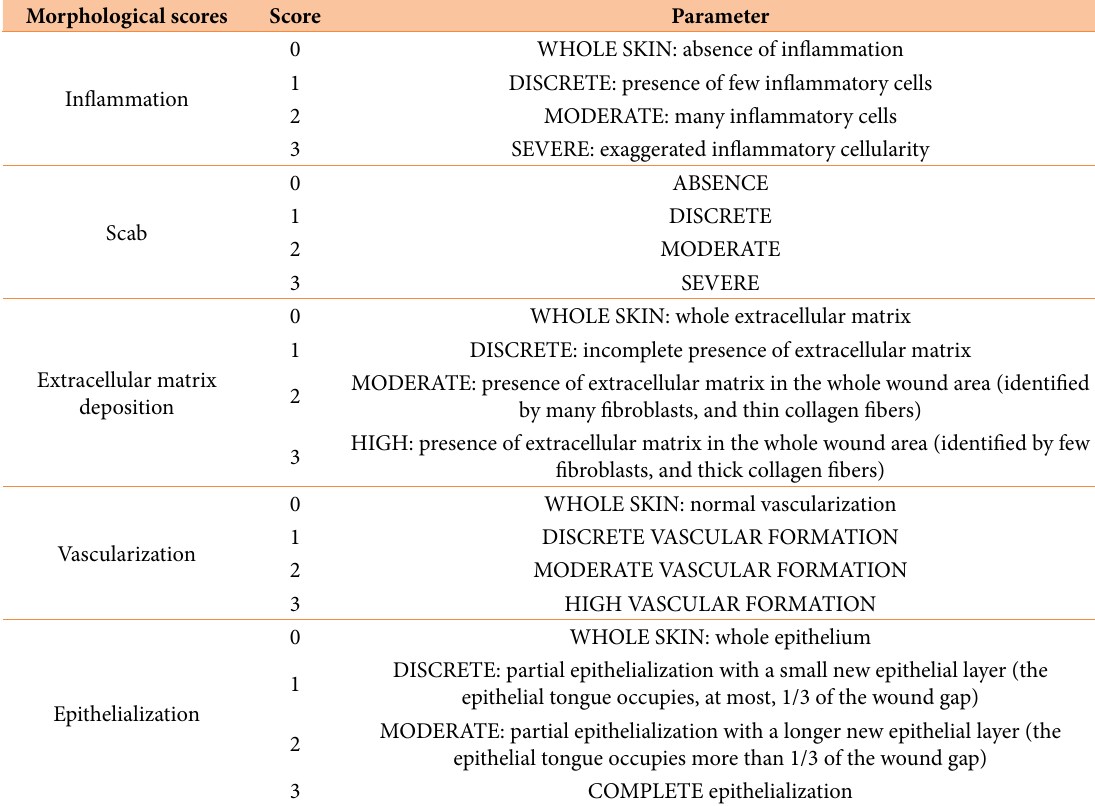
Table 1 - Morphological evaluation of wound healing events in the excisional wound healing model in rats 22 . Morphological